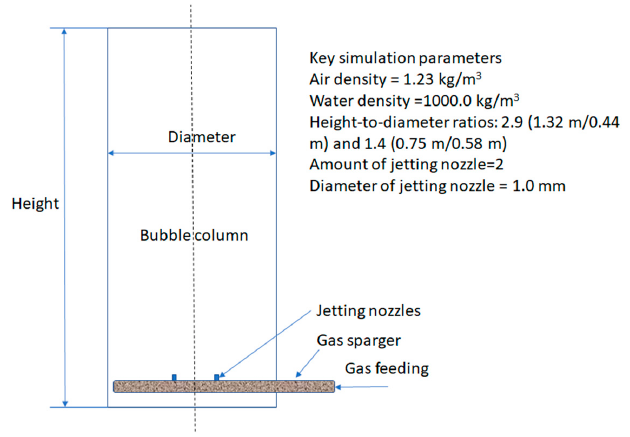
Figure 1. 2-D schematic of the sparged bioreactor in this simulation.